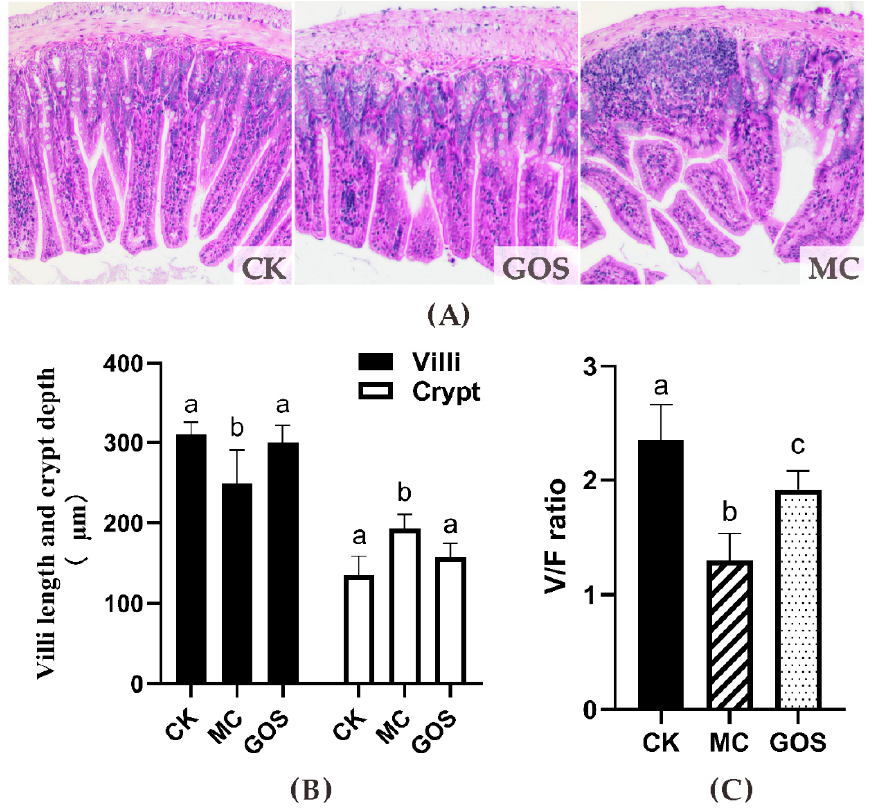
Figure 2 . Effect on the height of the villi and the depth of the fossae in the small intestine. ( A ) Photomicrographs in the small intestine of the mice (HE×100); ( B ) Height of the villi (V, μ m), depth of the crypts (F, μ m); ( C ) the V/F ratio. Different letters (a–c) show significant difference ( p < 0.05) in the same tissues among groups.